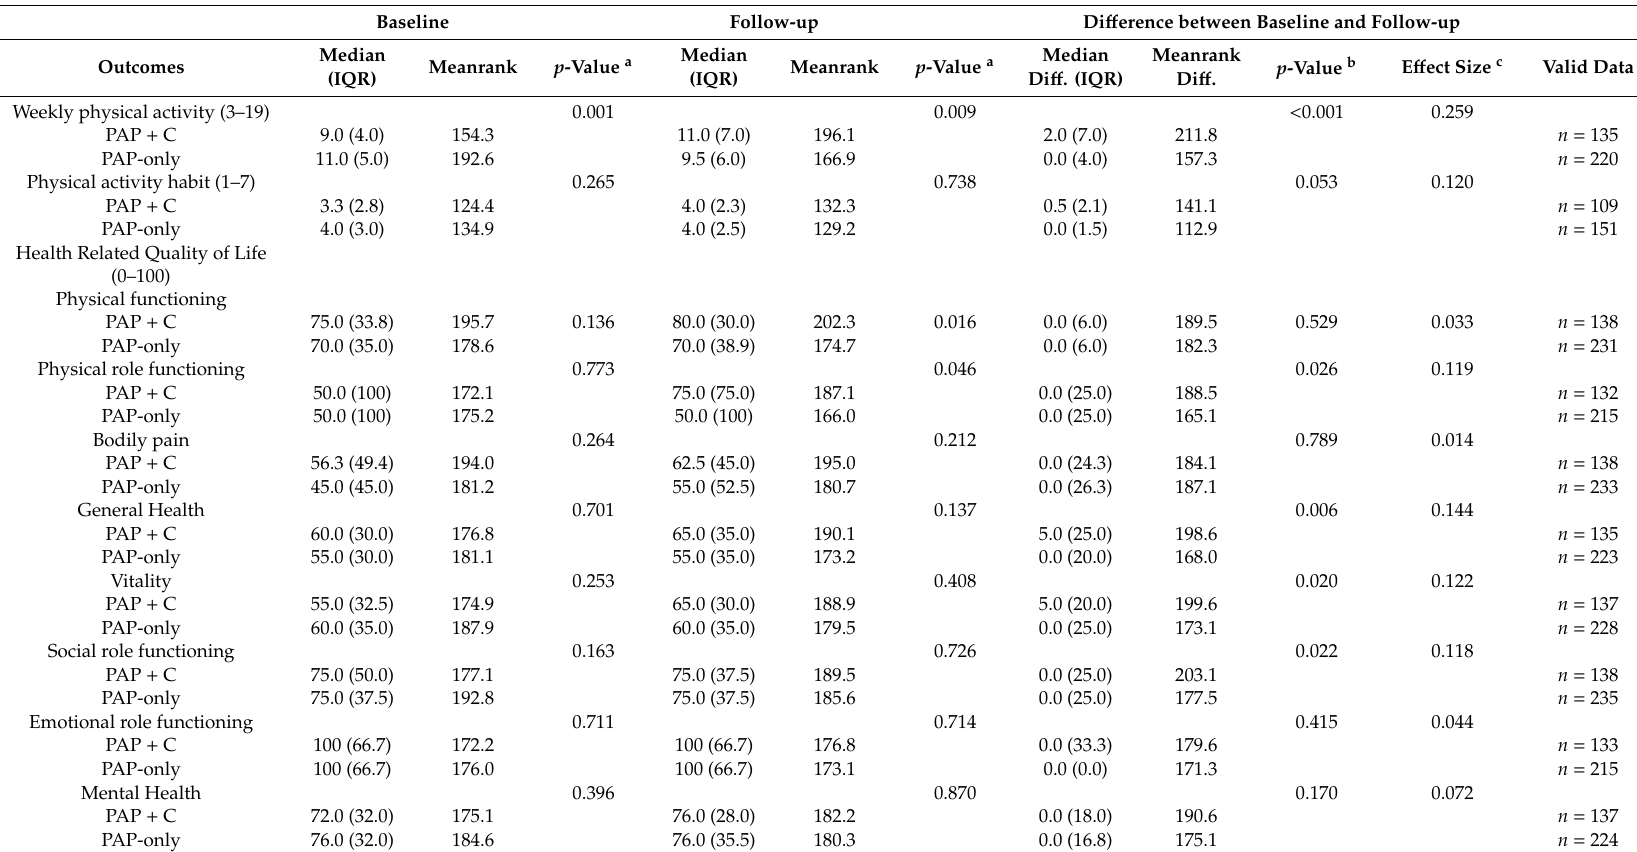
Table 2. Di ff erences between the study groups in weekly physical activity, physical activity habit and health-related quality of life (HRQoL) at baseline and follow-up, and di ff erences in e ff ects one year after